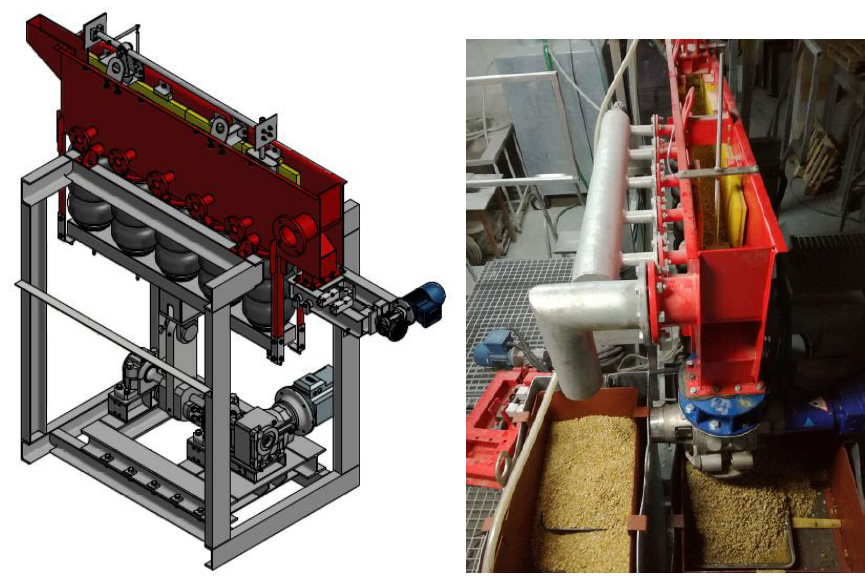
Table 3. Summary characteristics of individual tests. Figure 2. Model of the SET separator ( left ), device in plant conditions ( right ). Table 2. Characteristics of operational parameters of SET device.